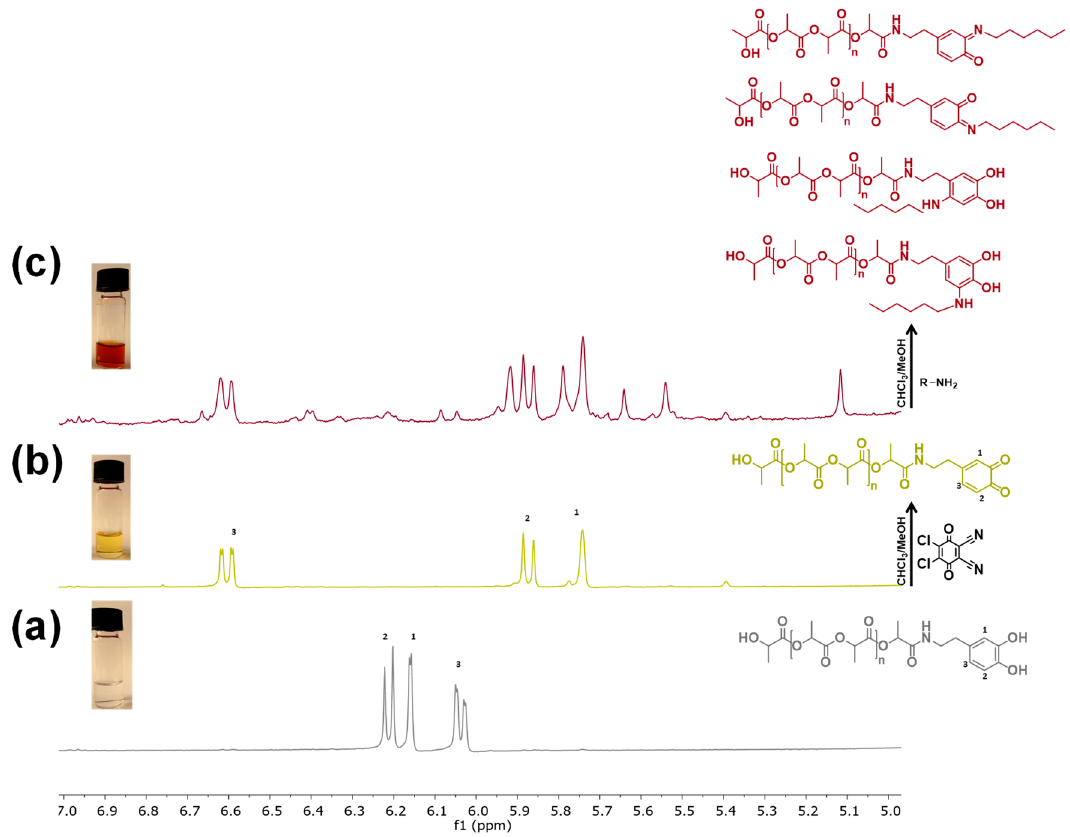
Figure 4. Scale spanded 1 H NMR of catechol-PLLA ( a ) before oxidation; ( b ) after oxidation and ( c ) after post-functionalizatoin with hexamethylenamine.